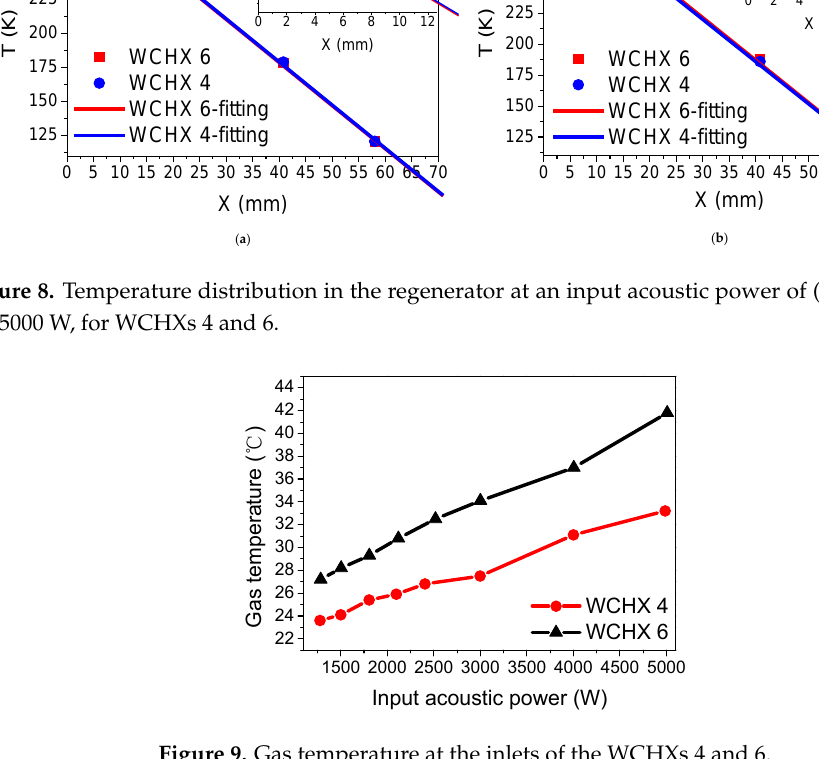
Figure 9. Gas temperature at the inlets of the WCHXs 4 and 6.